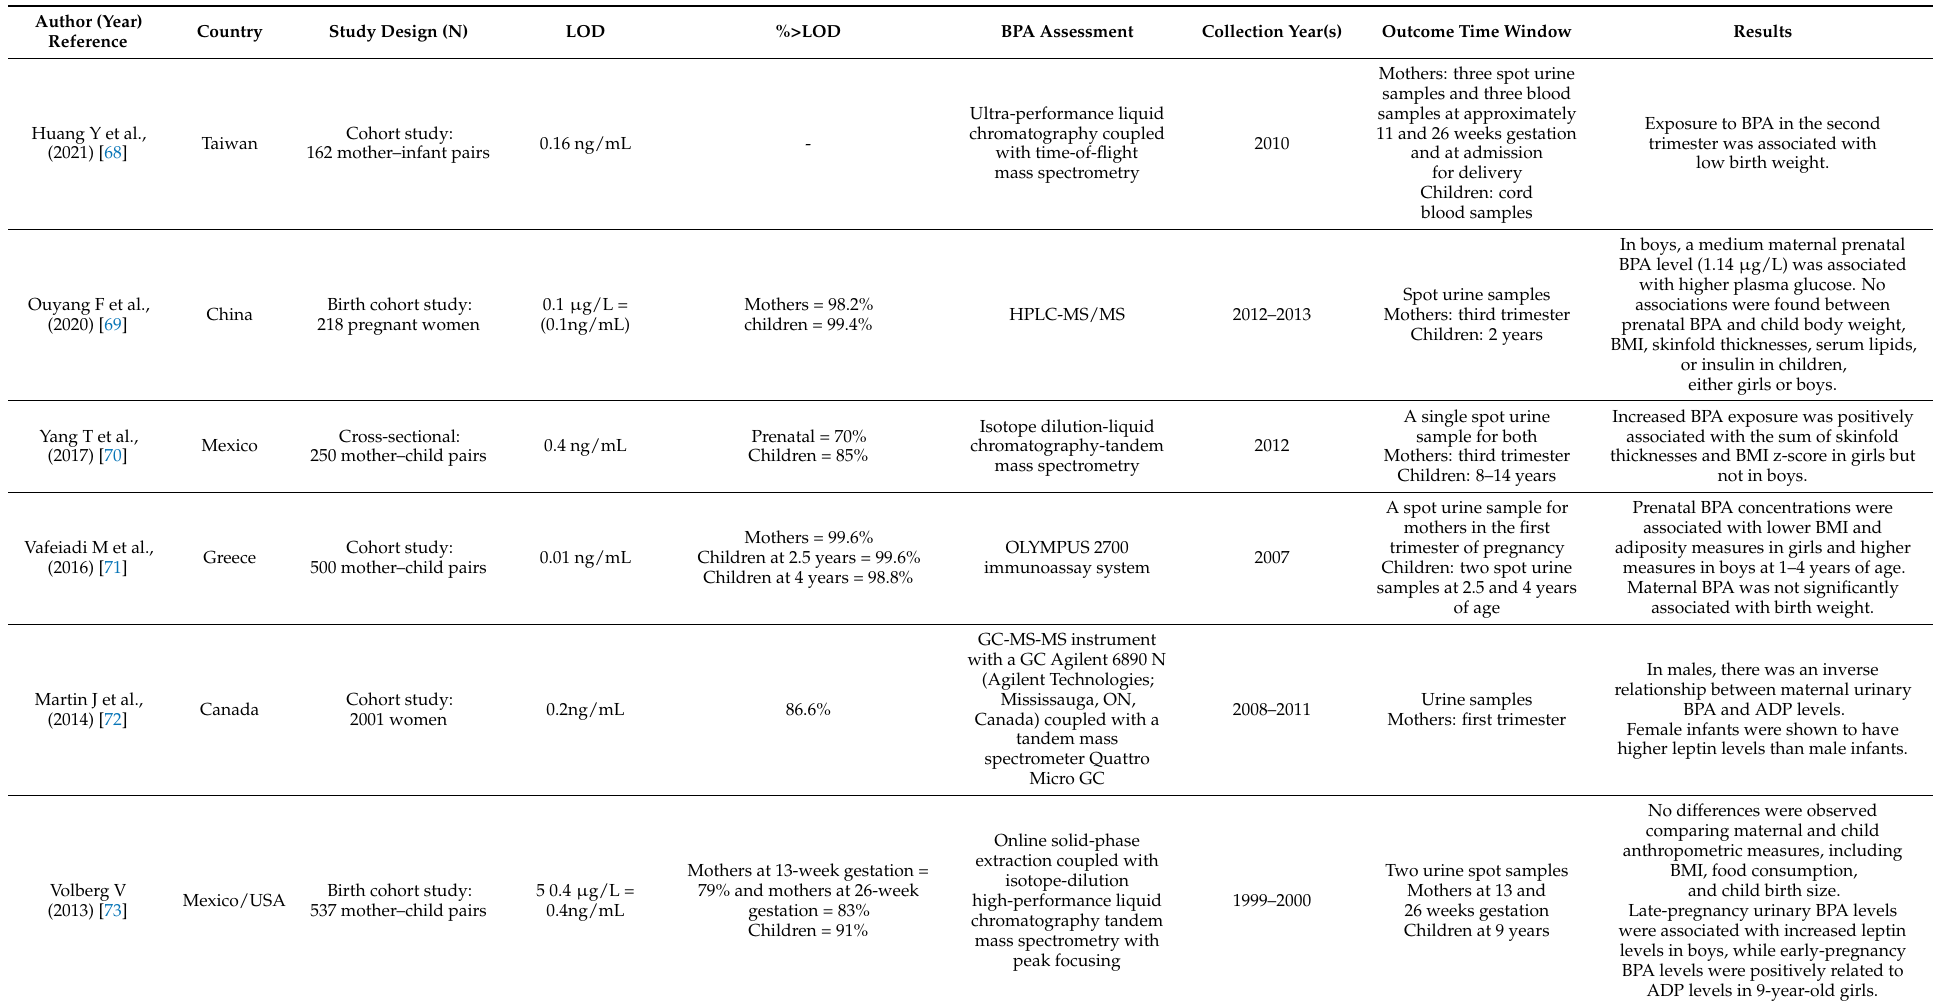
Table 3. Metabolic parameters observed in human studies following prenatal exposure to bisphenol